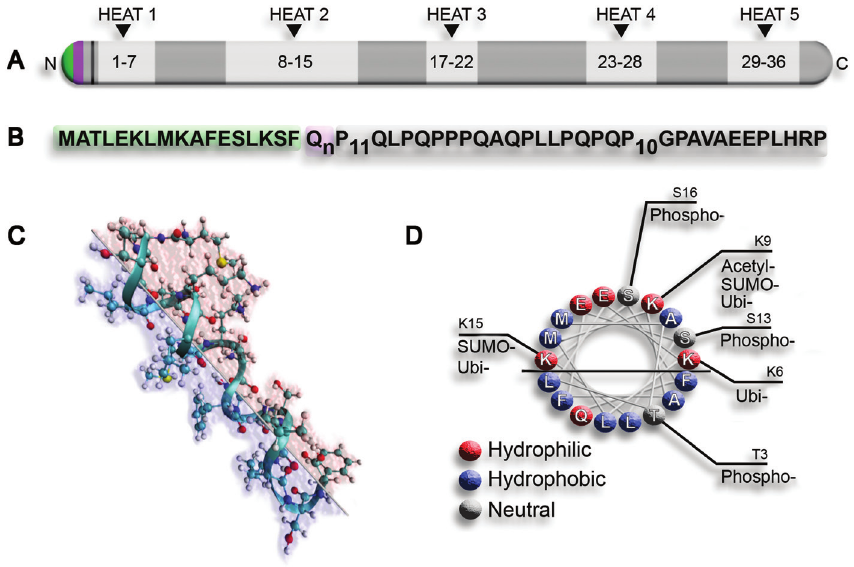
Figure 1: Schematic representation of various features of the huntingtin (htt) protein. (A) Full-length huntingtin protein with HEAT repeat sites (dark gray). The end of exon 1 is denoted by the black arrow. (B) Primary sequence of htt exon 1 indicating Nt17 (green), polyglutamine (polyQ) (purple), and the proline-rich region (gray). (C) Theoretical three-dimensional structure of Nt17 indicating hydrophilic (red) and hydrophobic (blue) faces of an amphipathic α -helix. (D) View down the barrel of the α -helix showing relative hydrophobicity of each residue (same color scheme as panel C), as well as the sites of reported posttranslational modification.